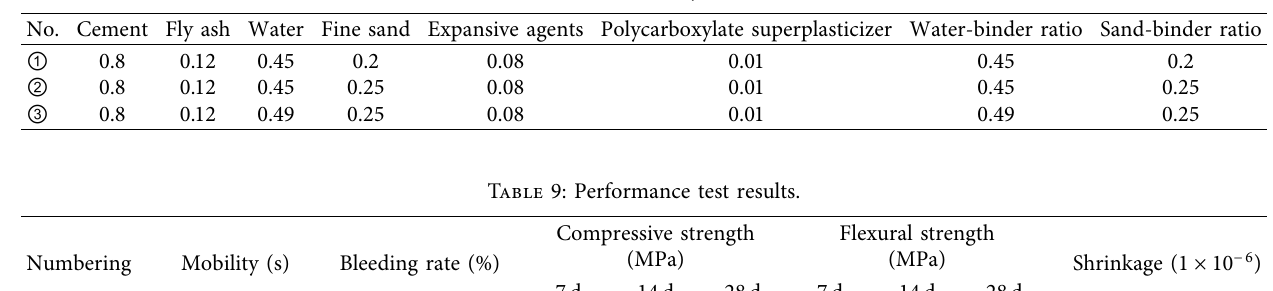
Table 8: Cement slurry mix ratios.